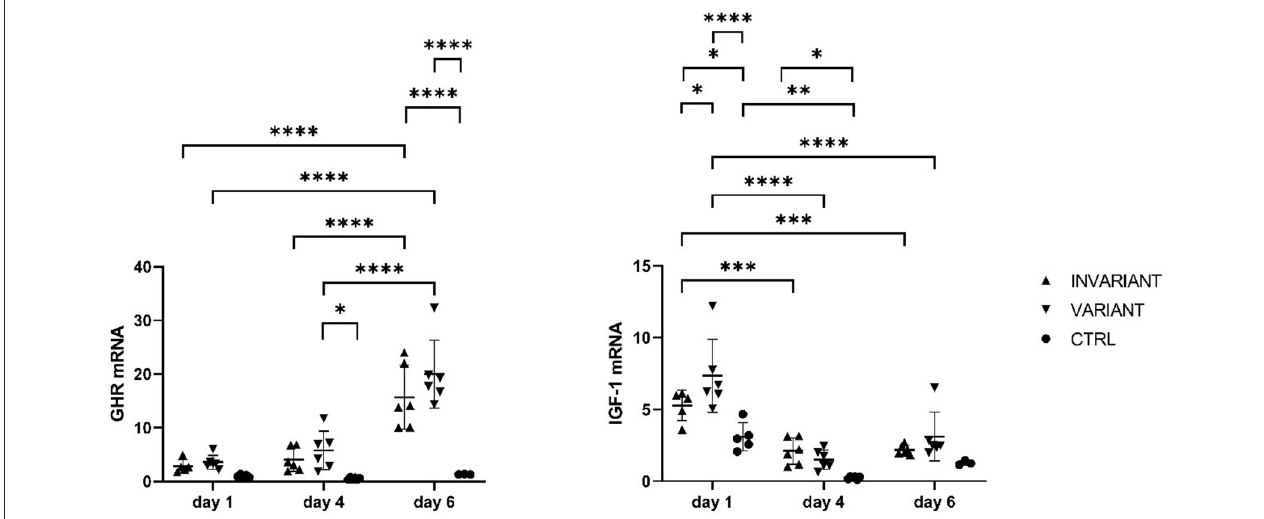
FIGURE 2 | Influence of T3 on GHR and IGF-1 mRNA expression in primary bovine hepatocytes. Relative mRNA expression in adult primary bovine hepatocytes after culturing 1, 4, and 6 days with high (INVARIANT) or varied (VARIANT) concentrations of triiodthyronine and no hormone substitute (CTRL). * P < 0.05, ** P < 0.01, *** P < 0.001, **** P <